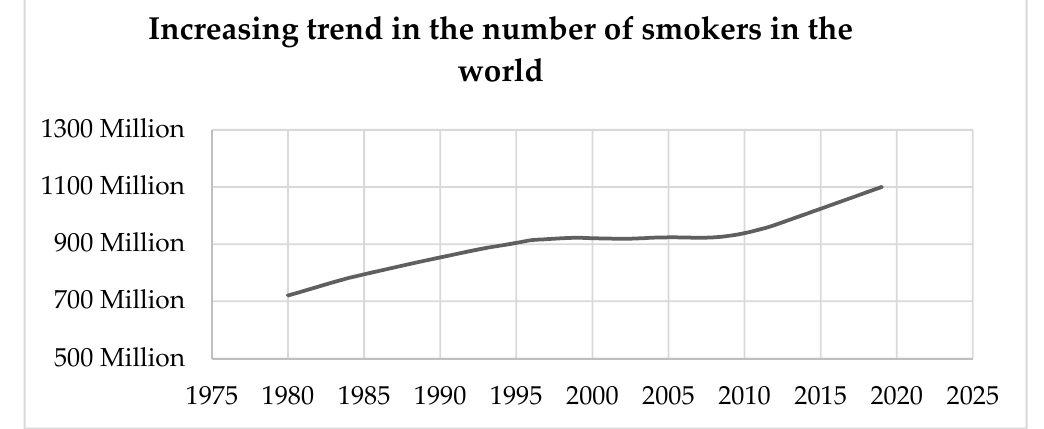
Figure 1. Increased rate of the number of daily smokers in the world from 1980–2019; adapted from the Institute for Health Metrics and Evaluation (2014) and World Health Organization [3,4].